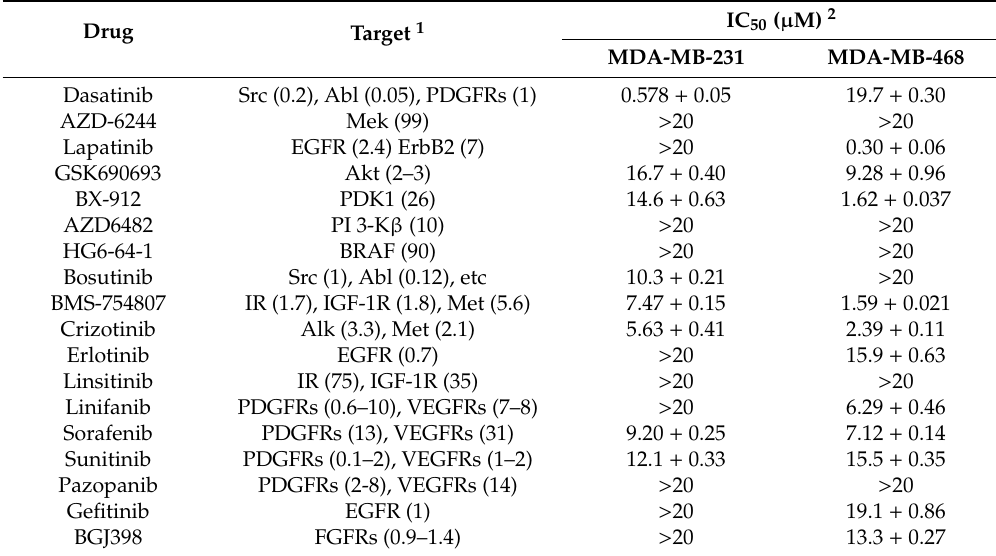
Table 1. Inhibition of MDA-MB-231 and MDA-MB-468 cell viability by protein kinase